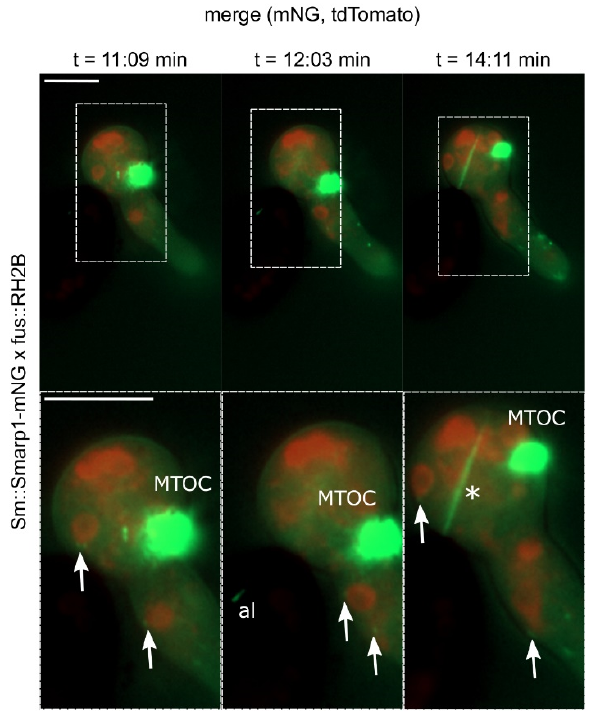
Figure 4. The dynamic localization of SmArp1-mNG in germinating S. macrospora ascospores. Selected images of Video S4, which tracks the germination of S. macrospora ascospores expressing Smarp1-mNG and red fluorescent histone 2B (RH2B tdTomato) on BMM-agar supplemented with agarose after incubation for 3–4 h at 27 °C. Arrows = localization of SmArp1-mNG close to nuclei; MTOC= putative microtubule organization center; al = SmArp1-mNG localization inside the ascospore; asterisk = SmArp1-mNG localization in fast appearing and dispersing linear structures; size bars = 10 µm; recording interval = 5 s.